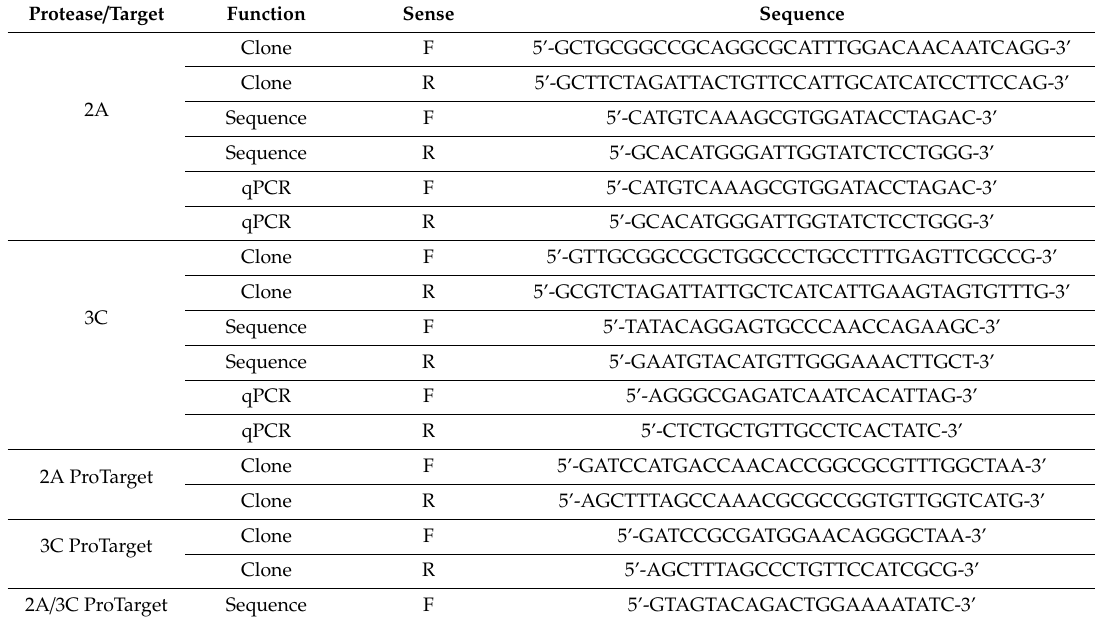
Table 1. Primers used in this